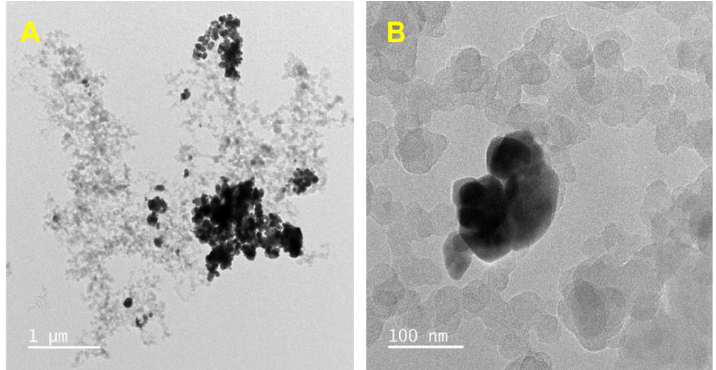
Figure 3. ( A , B ) TEM image of ZnWO 4 /CB composite.